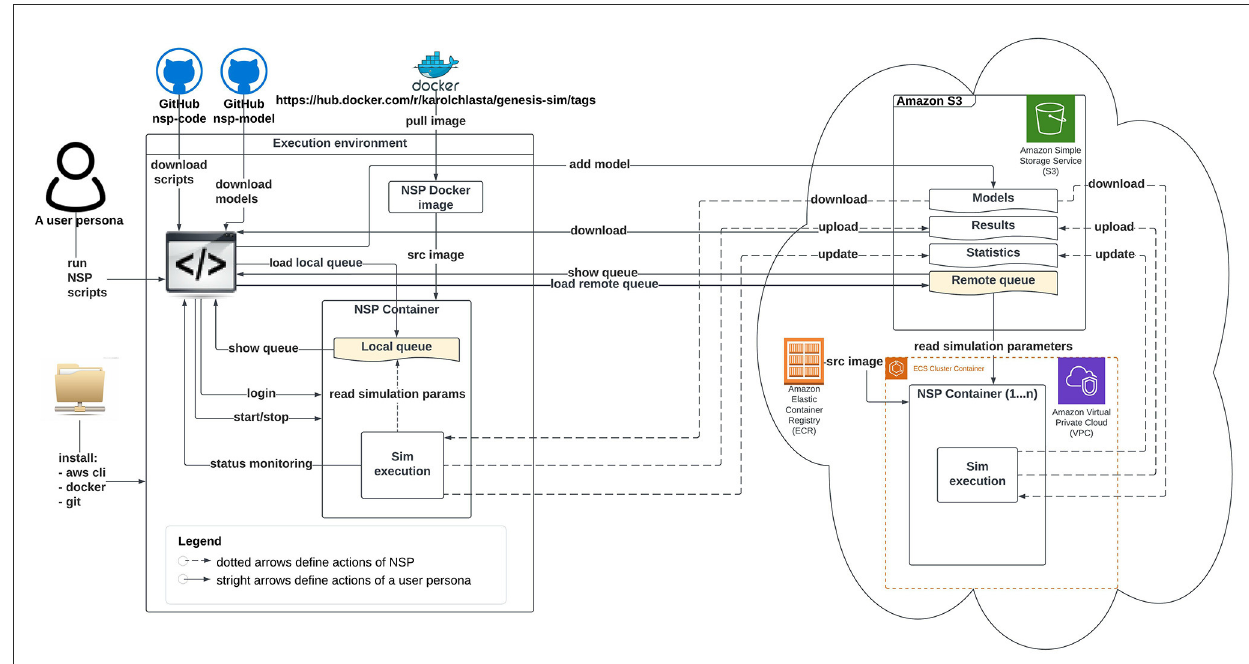
FIGURE2 Schematic diagram of neural simulation pipeline showing a user workflow. This persona interacts with the system via NSP scripts.